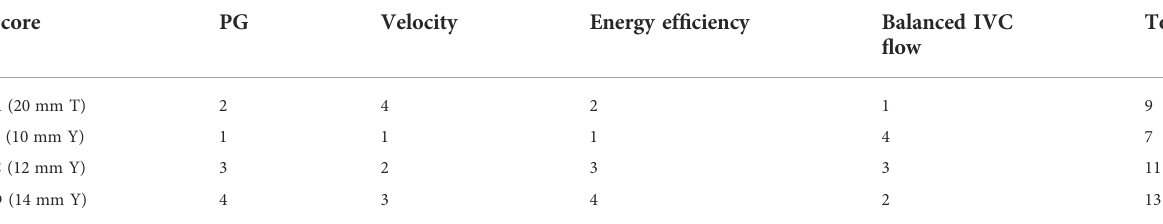
TABLE 2 The scores of each indicator for 4 groups.